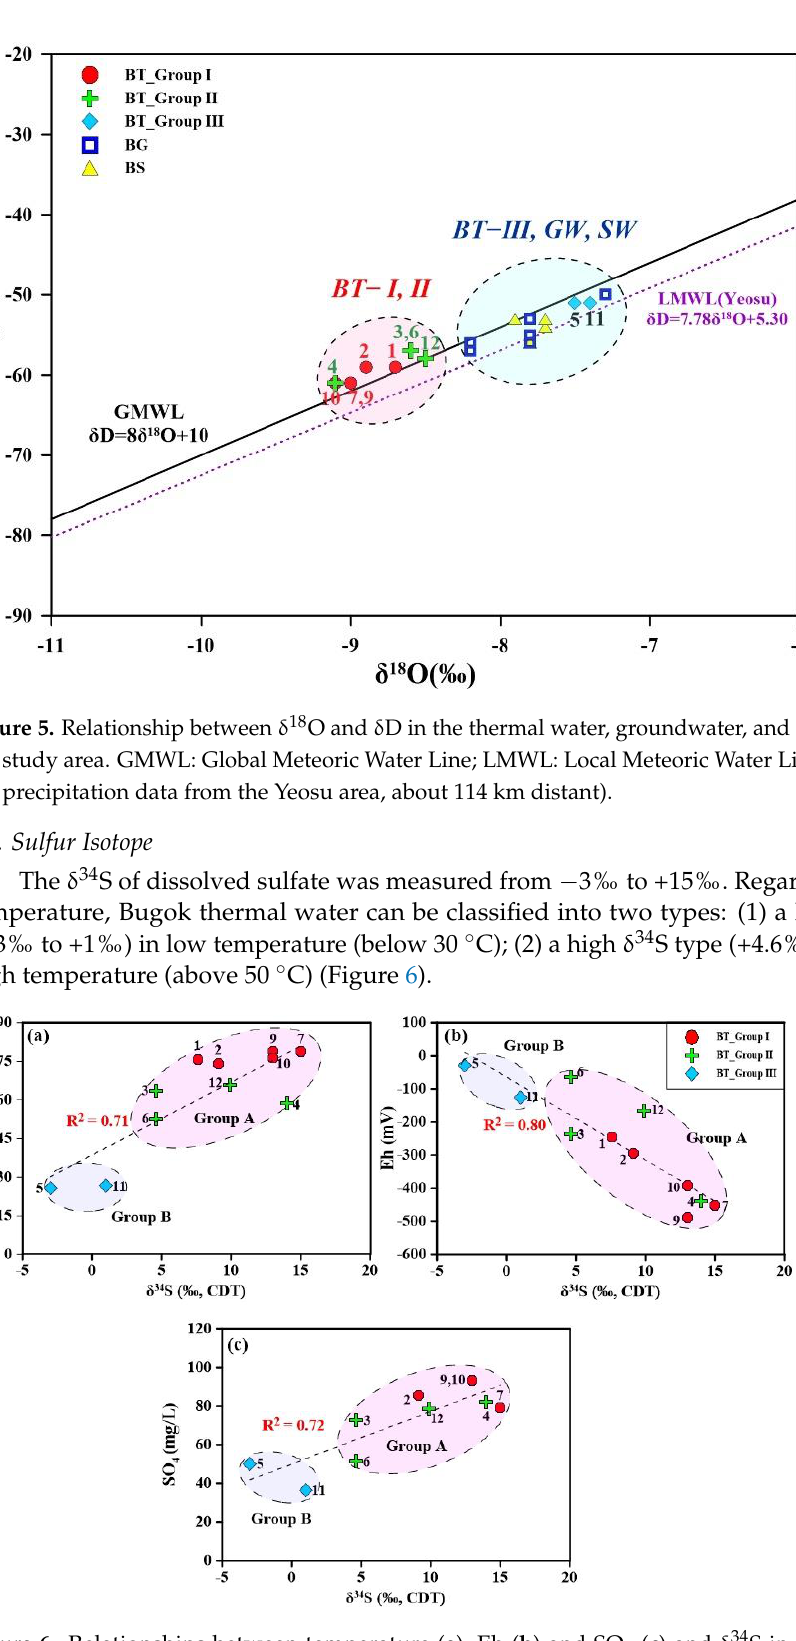
Figure 6. Relationships between temperature ( a ) , Eh ( b ) and SO 4 ( c ) and δ 34 S in Bugok thermal waters. BT 1 sample showing an exceptionally high SO 4 concentration in ( c ) the graph was excluded for statistical significance.